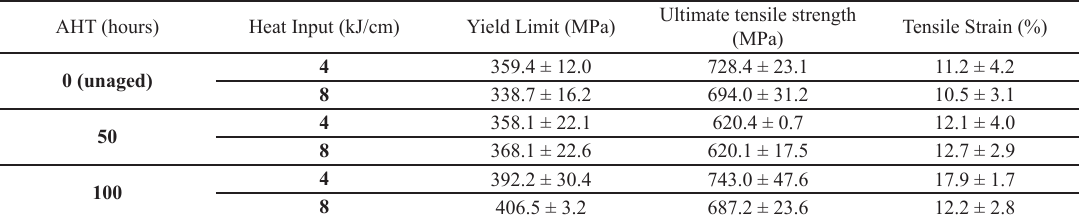
Table 7. Mechanical properties